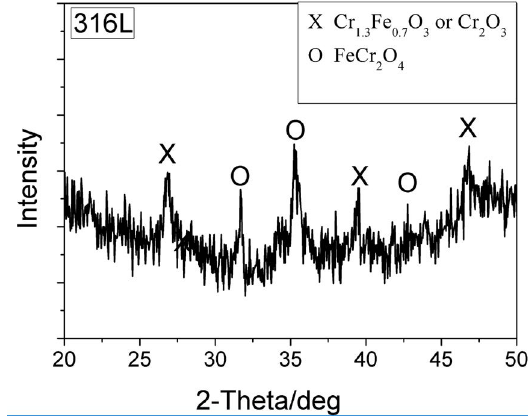
Figure 14. XRD patterns of the corrosion product of the 316Lsteel after exposure tests (CuKα, λ = 0.1540 nm).